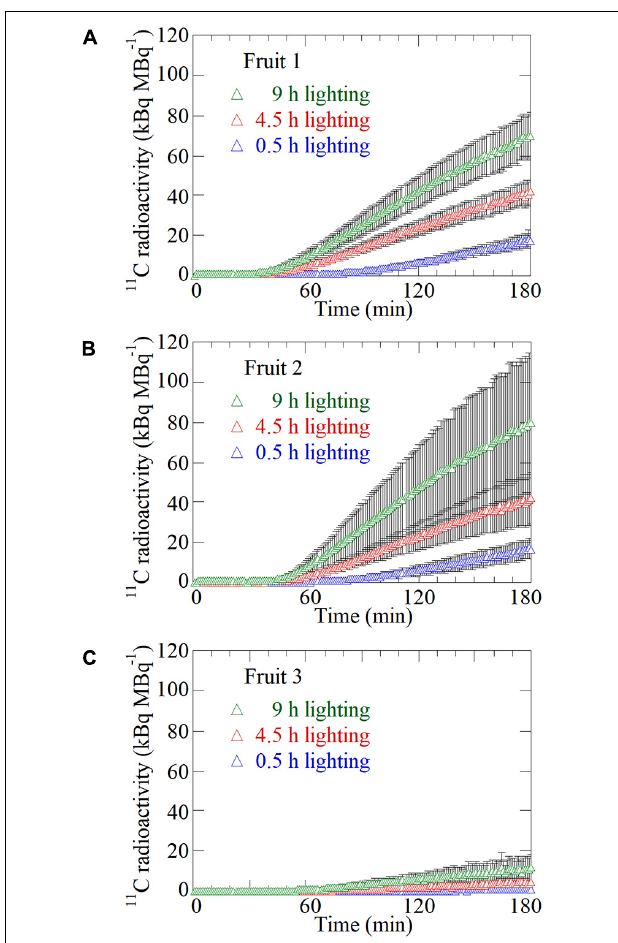
FIGURE 4 | Time-course analysis of average 11 C radioactivity in the ROIs of (A) Fruit 1, (B) Fruit 2, and (C) Fruit 3 for all the plants in response to the 0.5-, 4.5-, and 9-h lighting treatments. The black bar on each plot represents the standard deviation. The data were normalized against the 11 C-radioactivity assimilated by the source leaf during each PETIS imaging